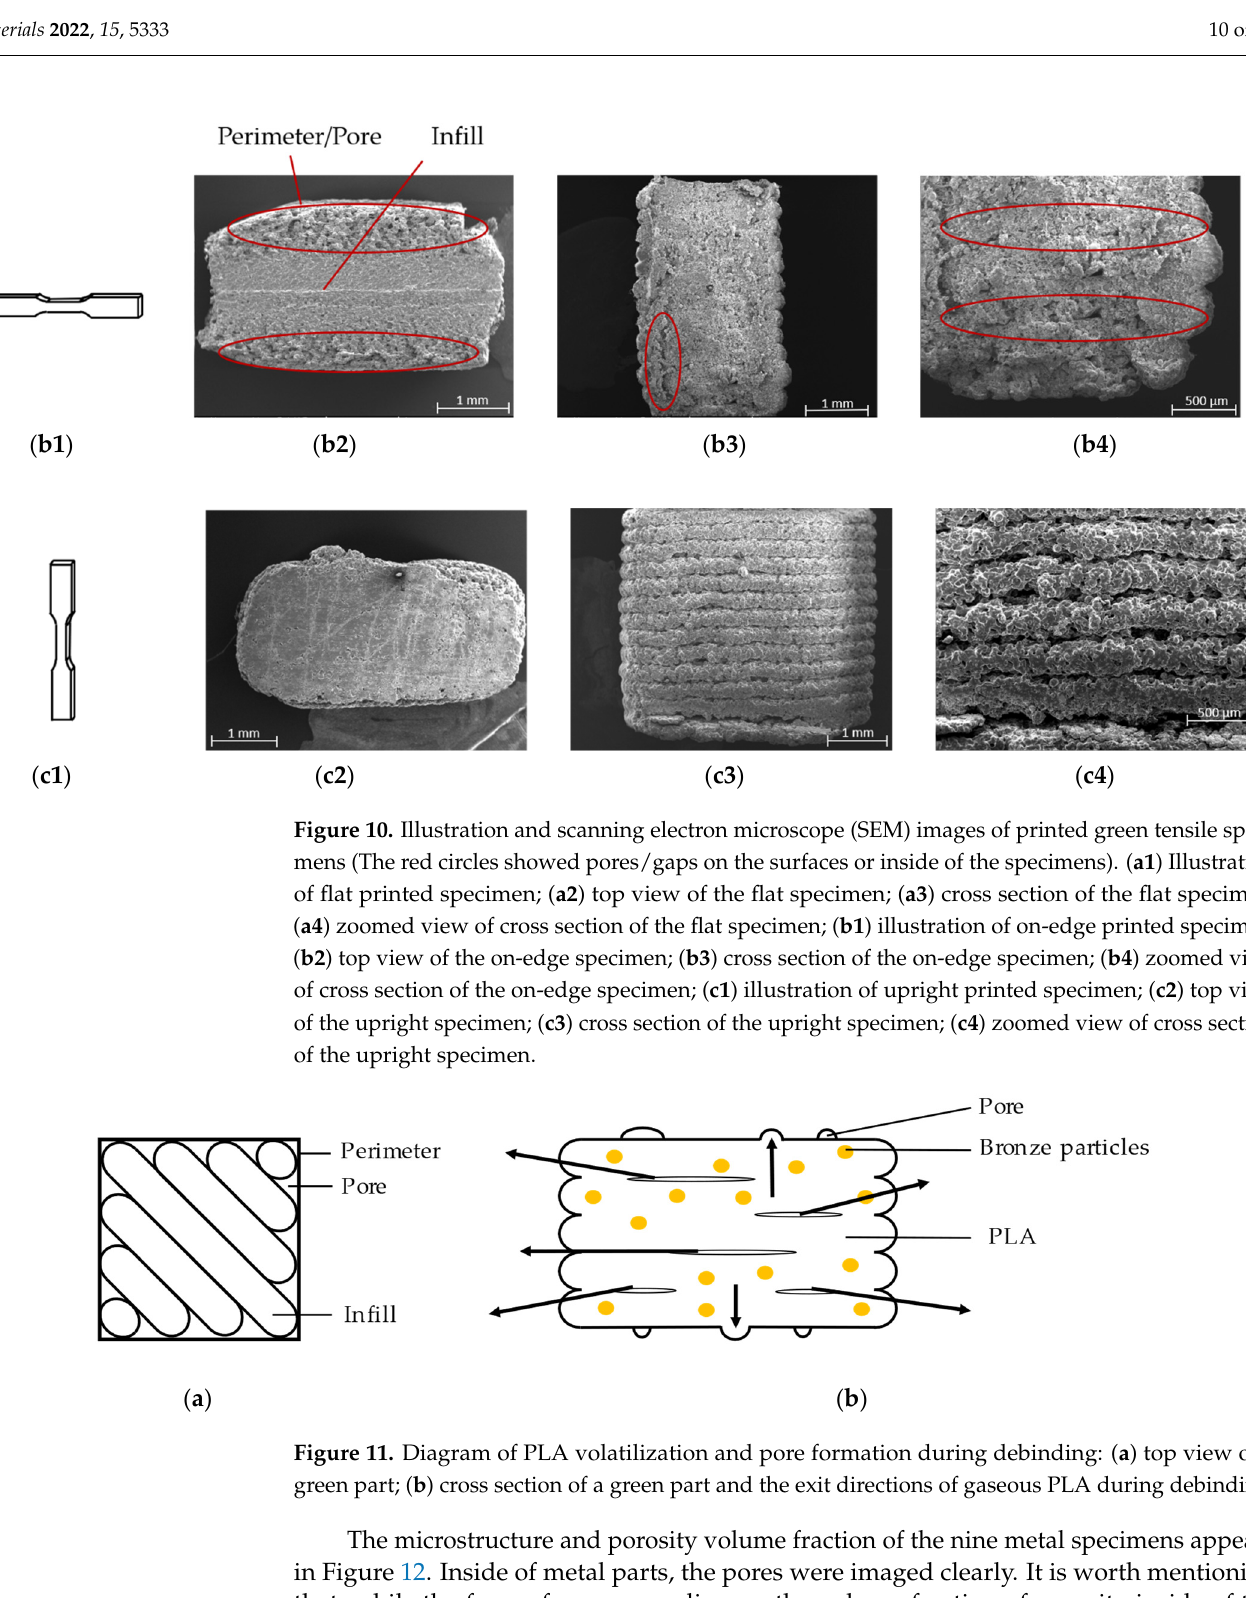
Figure 11. Diagram of PLA volatilization and pore formation during debinding: ( a ) top view of a green part; ( b ) cross section of a green part and the exit directions of gaseous PLA during debinding.